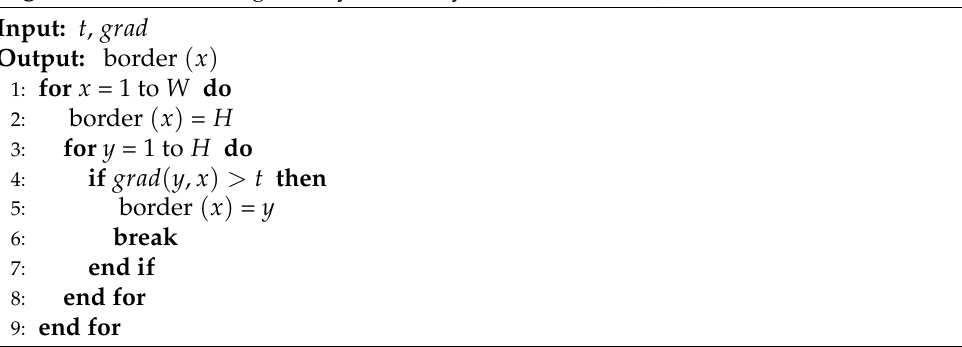
Algorithm 1 Calculating the sky boundary function border ( x